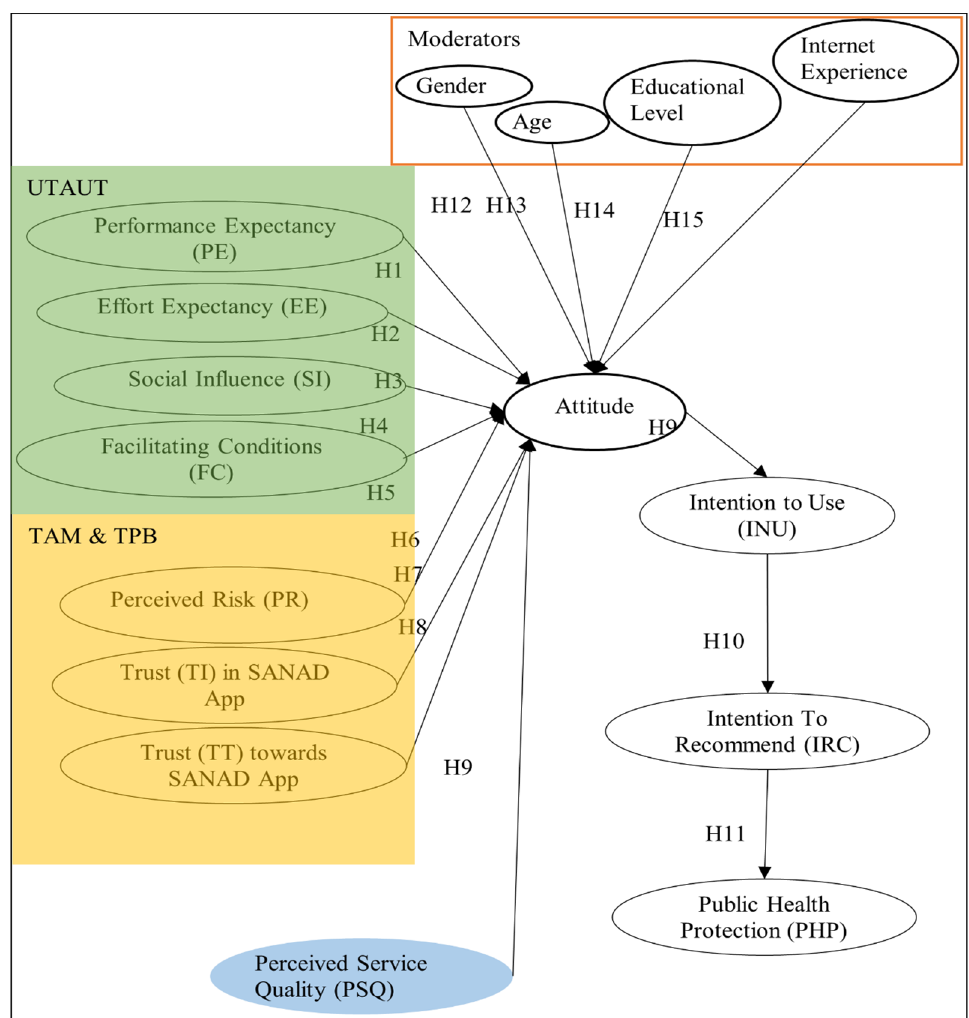
Figure 1. A suggested model of the